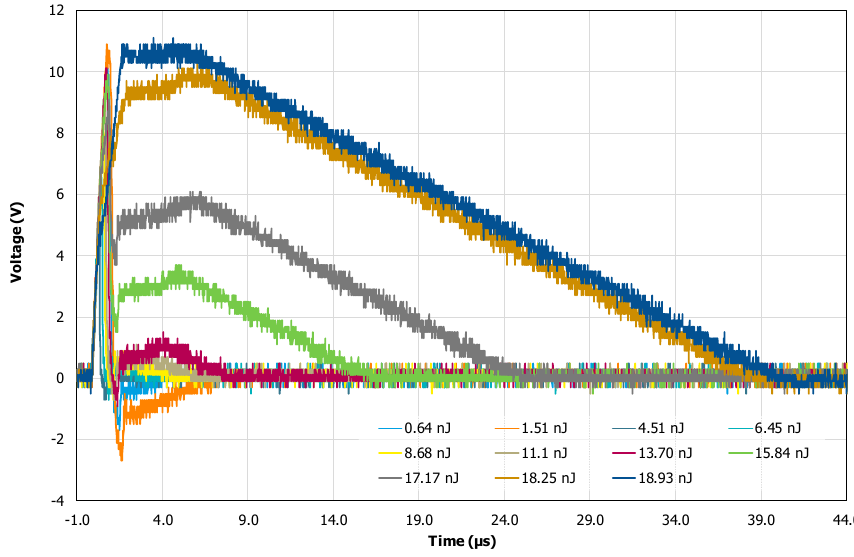
Figure 9. The response of the region R1 to 1064 nm photons at different incident pulse energies.